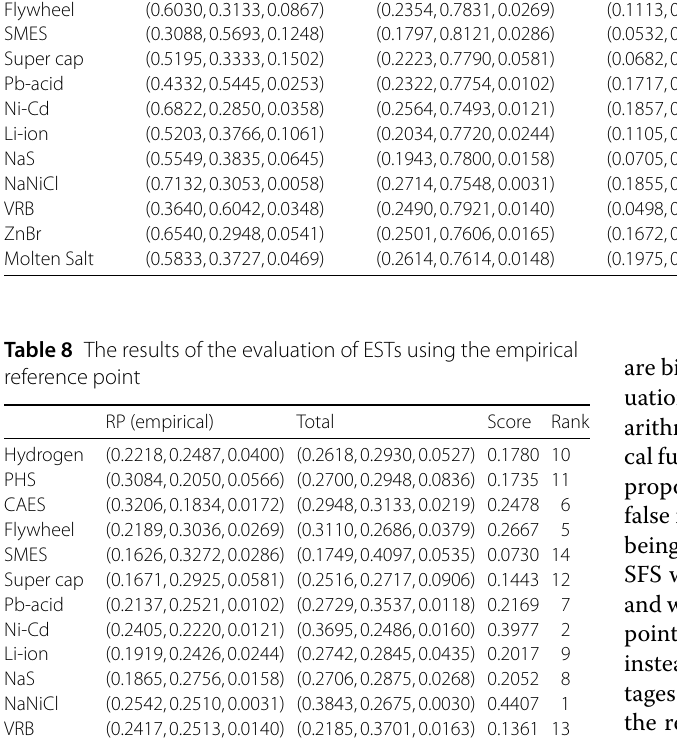
Table 7 The results of the evaluation of ESTs using the theoretical reference point SFWA RP (theoretical) SFWG Hydrogen